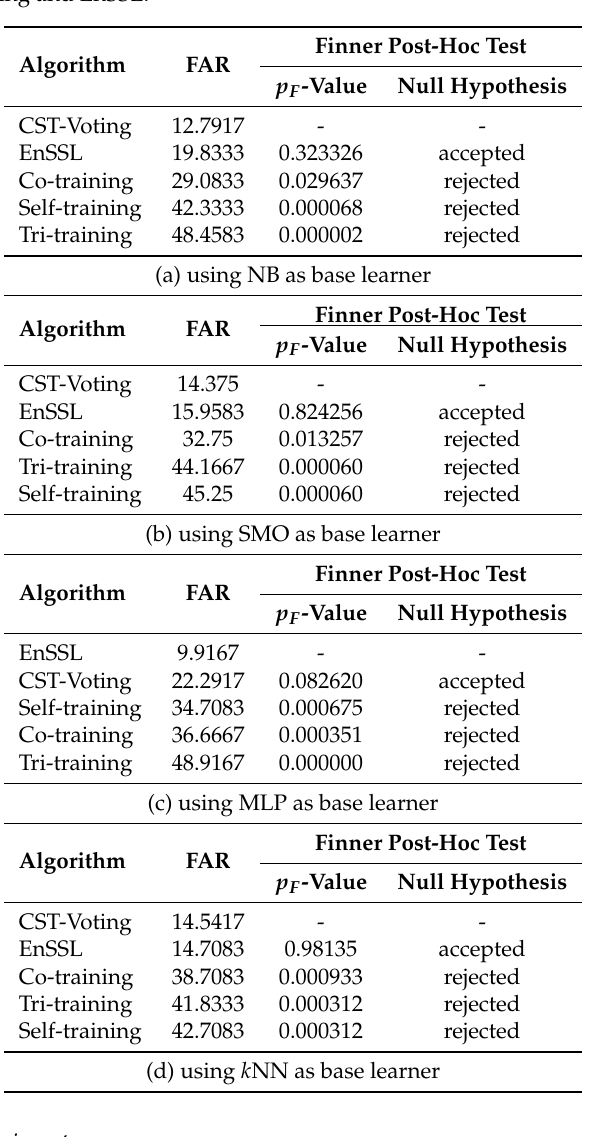
Table 5. Friedman Aligned Ranking (FAR) test and Finner post-hoc test for Self-training, Co-training, Tri-training, CST-Voting and